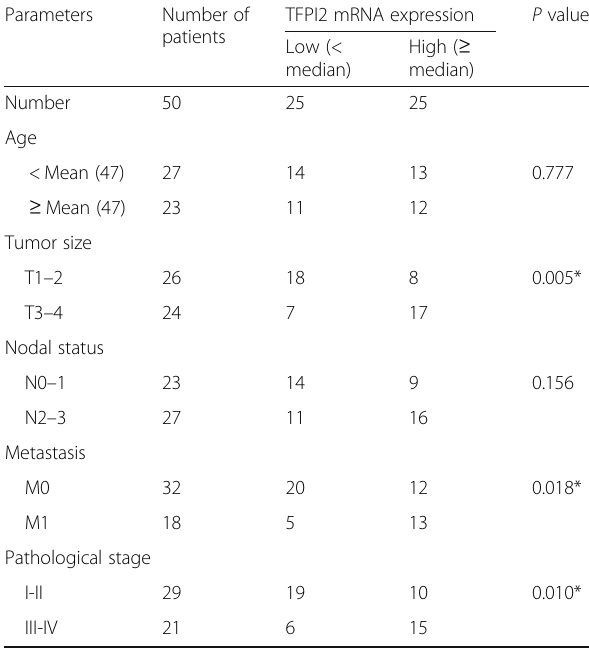
Table 2 Relationship between TFPI2 mRNA and clinico- pathological